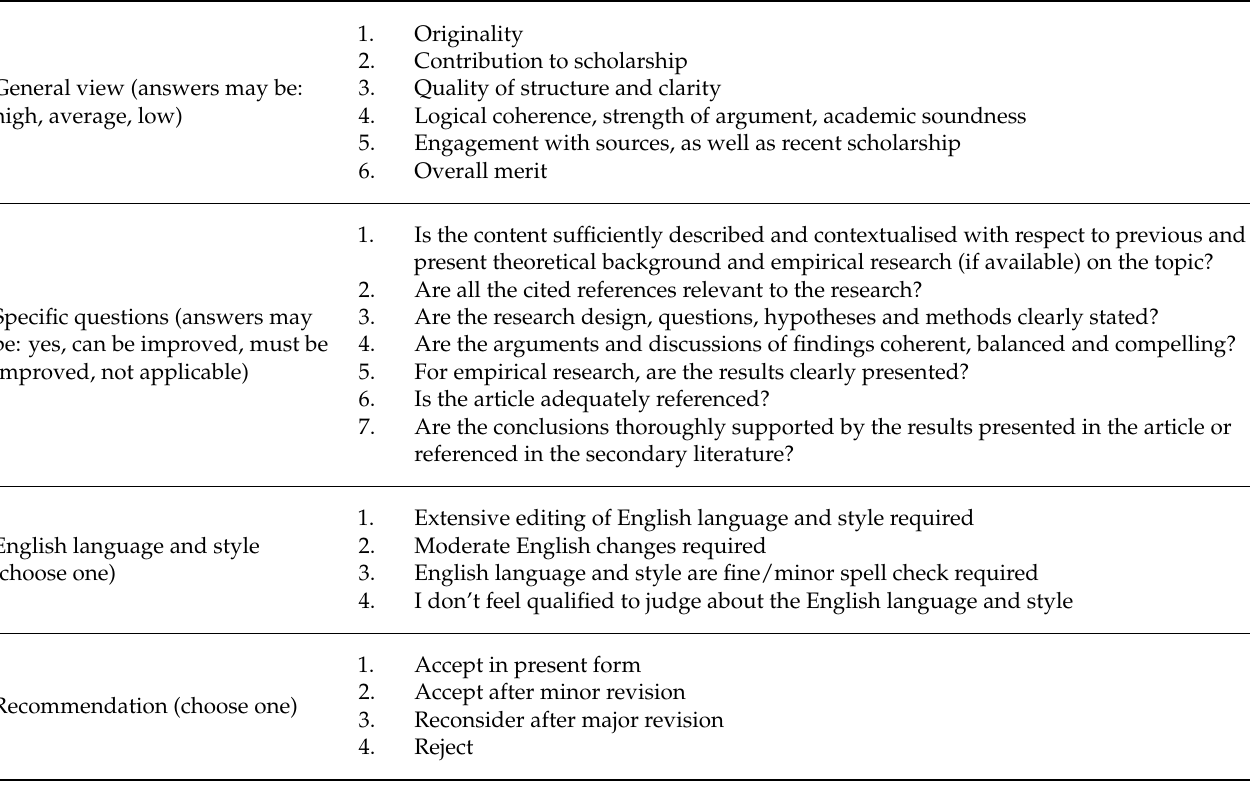
Table 1. Closed responses in a reviewer